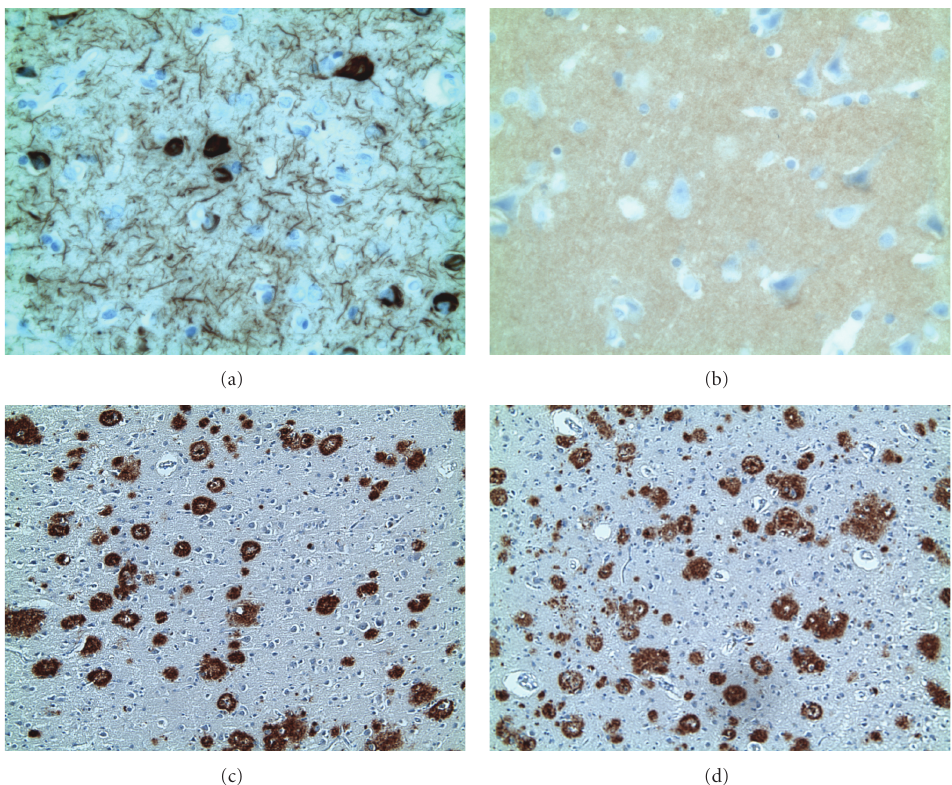
Figure 1: Photomicrographs illustrating the two cases’ similarity of amyloid A β 42 plaques and marked di ff erence in AD-like pathology. Panel (a) shows tau pathology with NFT and neuropil threads of case 1 which are absent in case 2 (panel (b)). Panels (c) and (d) show equally high A β 42 plaque densities of cases 1 (c) and 2 (d). Location: prefrontal cortex (middle frontal gyrus); immunohistochemistry: tau-5 ((a) and (b)) and 21F12 ((c) and (d)); magnification: 400X ((a) and (b)) and 100 X ((c) and (d)).